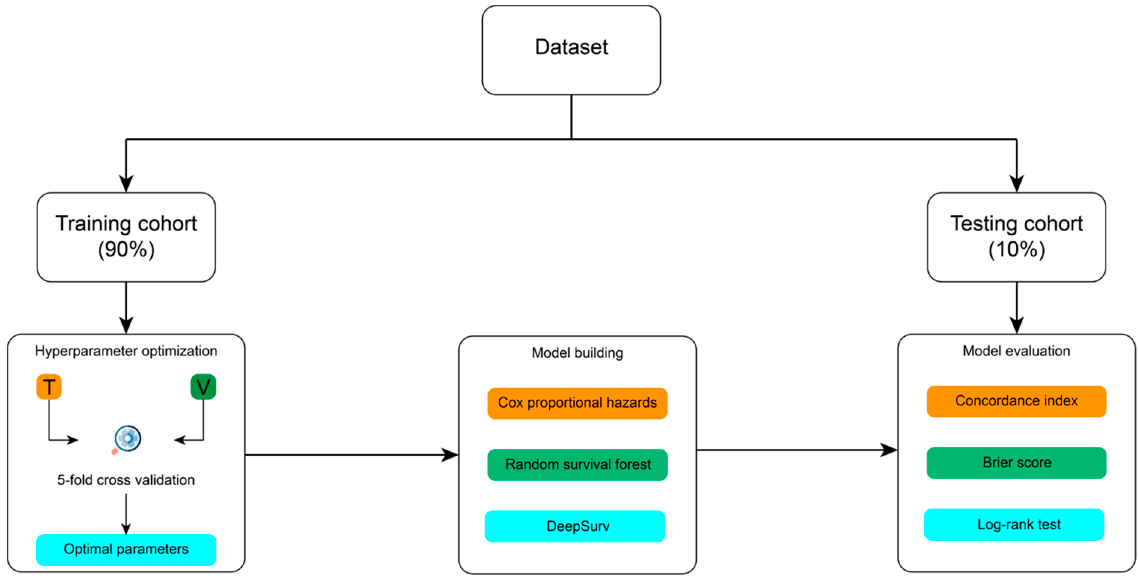
Figure 6. Illustration of the modelling framework.